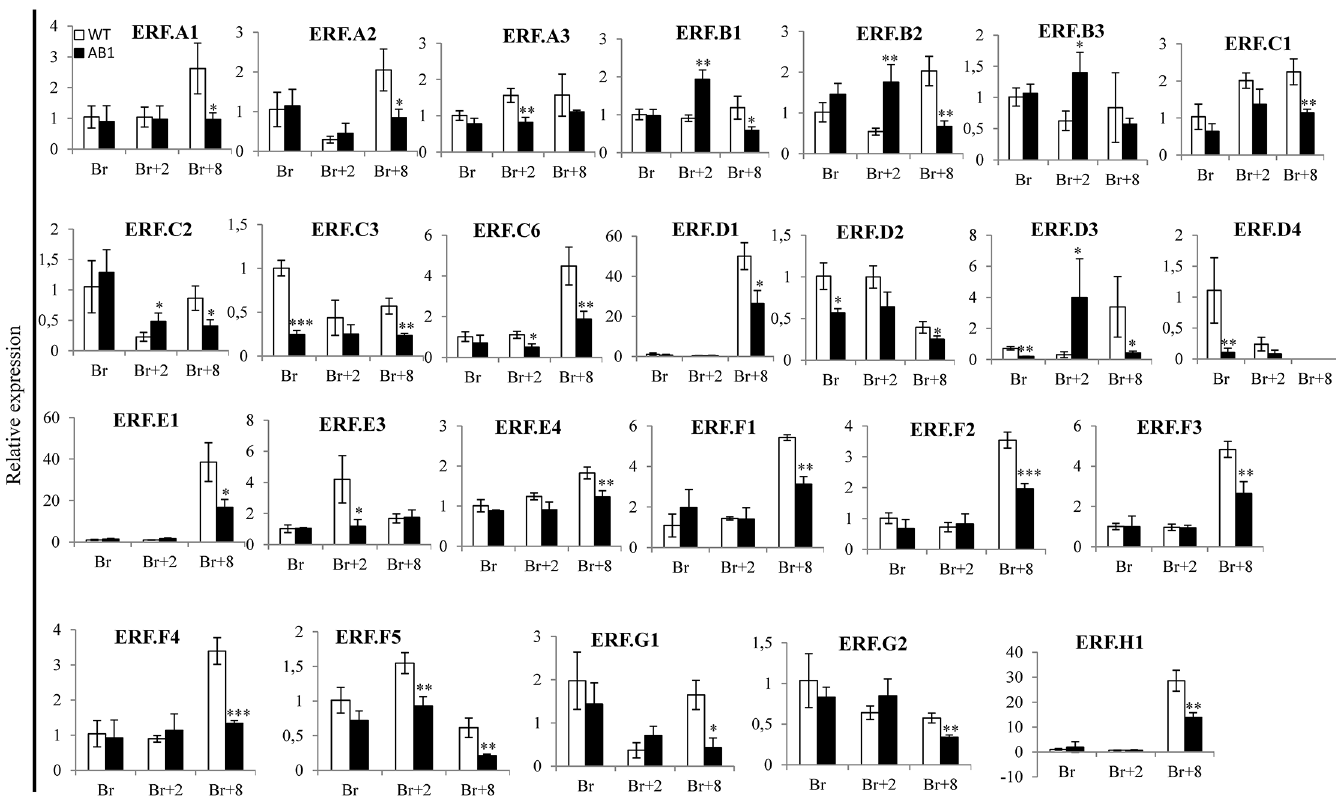
Fig 9. The expression of ERF genes in wild type and SlARF2AB-RNAi plants. Expression of ERF family genes in SlARF2AB-RNAi fruits assessed by Quantitative RT-PCR. Total RNA was extracted from different fruit developmental stages (breaker, Br; Br+2, 2 days post-breaker; Br+8, 8 days post-breaker). The relative mRNA levels of each gene in WT at the breaker (Br) stage were standardized to 1.0, referring to the SlActin gene as internal control. Error bar means ± SD of three biological replicates. Stars indicate statistical significance using Student ’ s t-test: * p-value < 0.05, ** p-value < 0.01. ABL1 refers to SlARF2AB-RNAi line